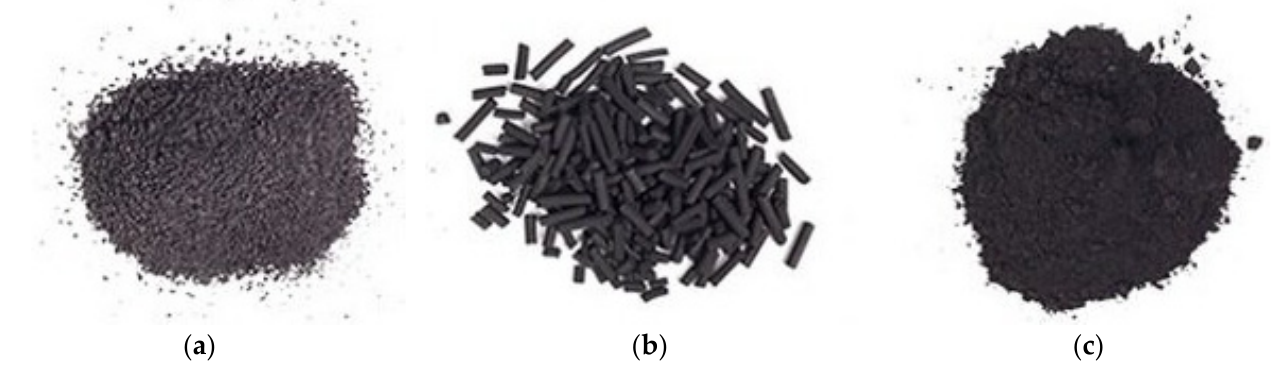
Figure 3. Representation of ( a ) granular, ( b ) pelletized and ( c ) powdered types of activated carbons. Reprinted with permission from Ref. [92].